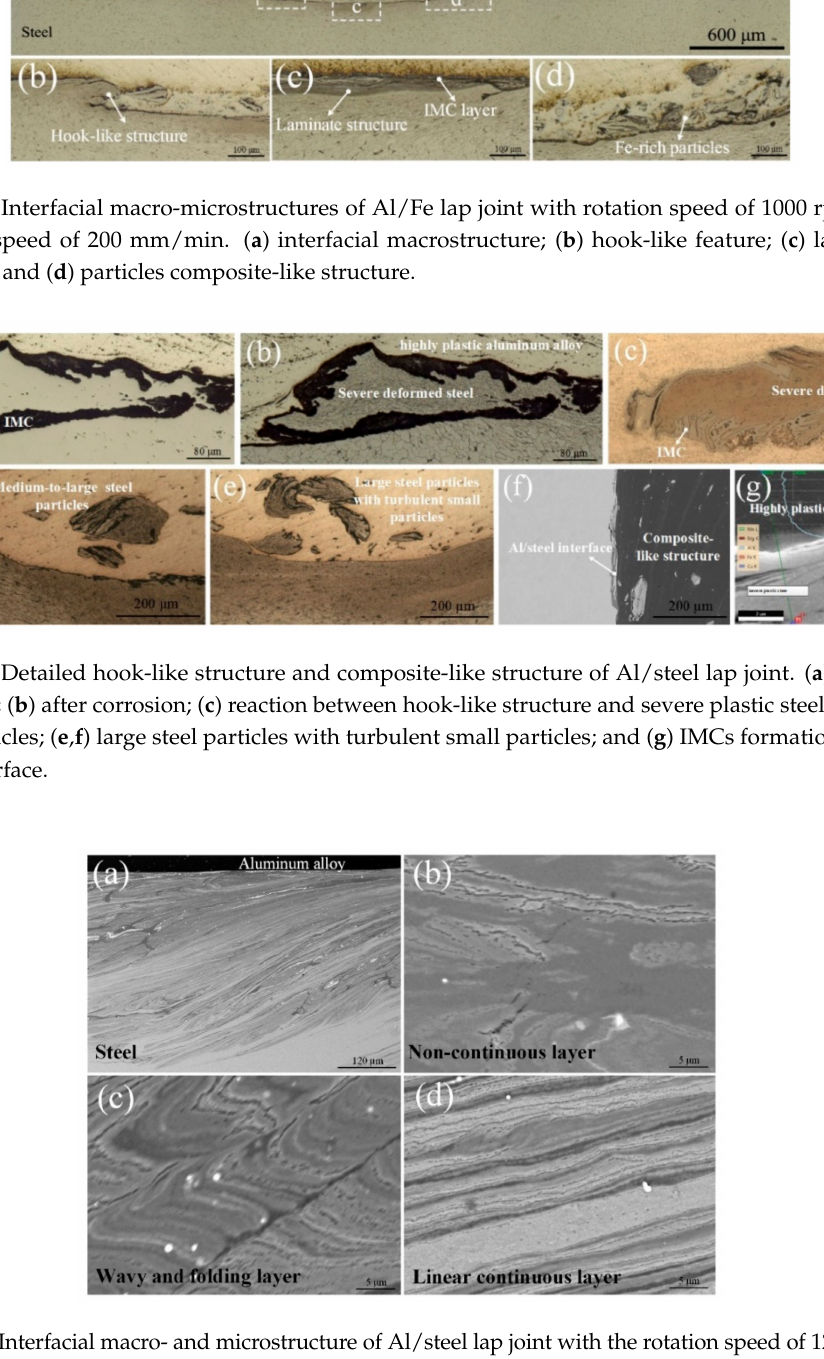
Figure 9. Interfacial macro- and microstructure of Al/steel lap joint with the rotation speed of 1200 rpm and welding speed of 200 mm/min. ( a ) Interfacial macrostructure; ( b ) non-continuous layer; ( c ) wavy and folding layer; and ( d ) linear continuous